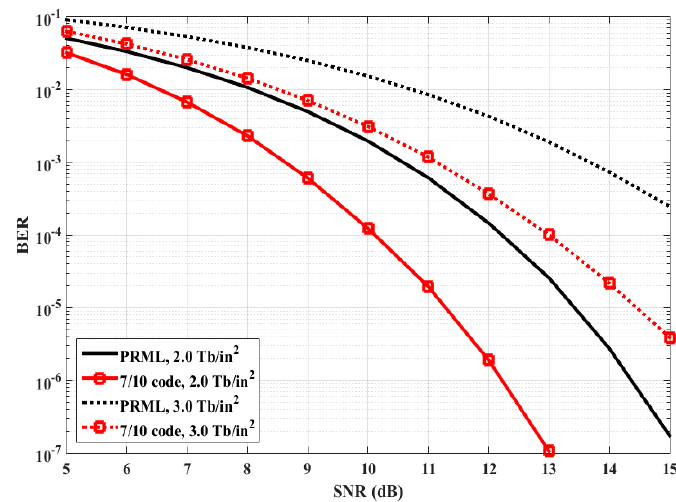
Figure 5. The bit error rate (BER) performance of the partial response maximum likelihood (PRML) and the proposed 7 / 10 modulation code at the same areal densities (AD).